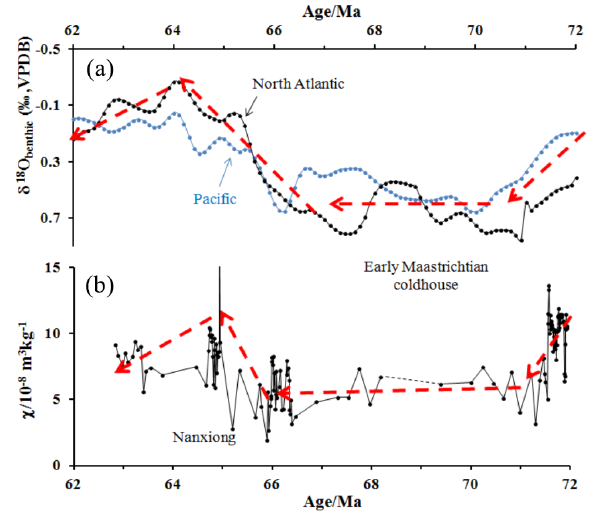
Figure 8. Correlations between δ 18 O from Pacific and North At- lantic records (a) and χ from the Datang profile (b) from 72 to 62.8Ma; higher δ 18 O values correlate with lower χ